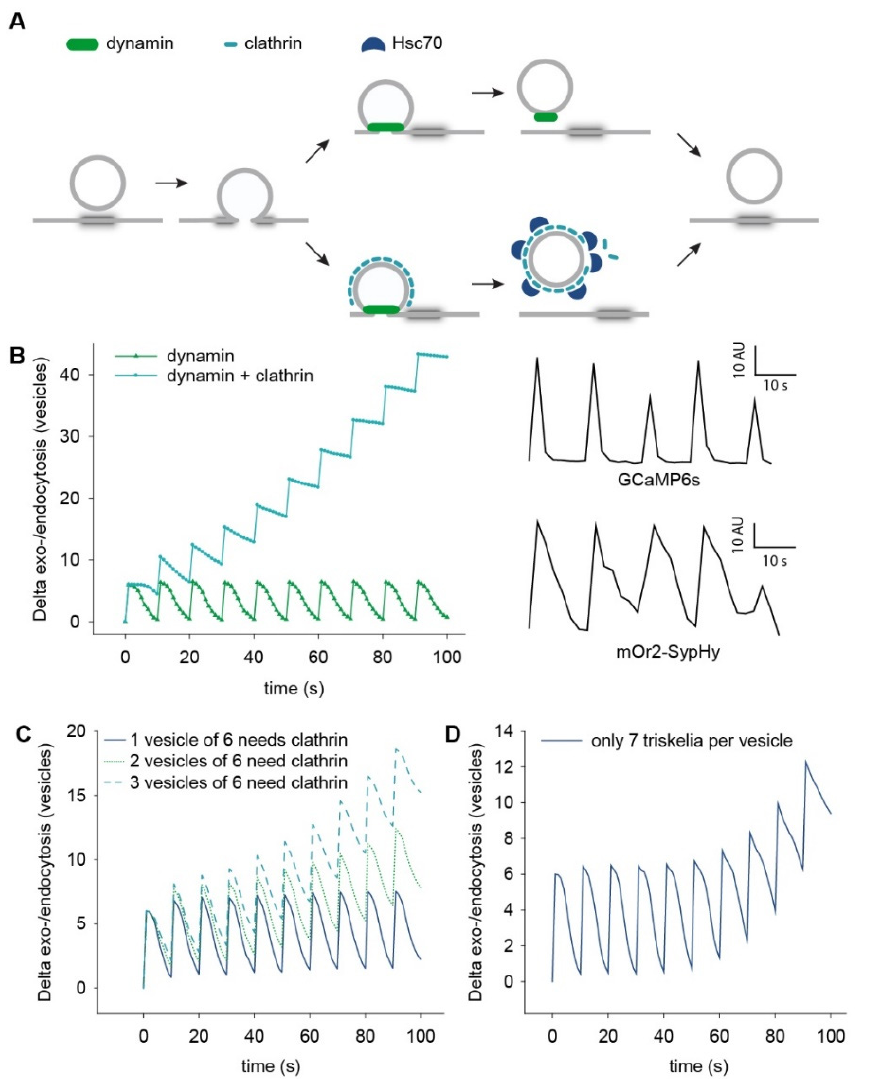
Figure 2. Simulations of the usage of three endocytosis cofactors during spontaneous network activity, ( A ), models of endocytosis tested in the simulations. To be endocytosed, each vesicle either needs to accumulate a su ffi cient number of dynamin molecules, which are quickly released after endocytosis, or, in addition to dynamin, a full clathrin coat is also required, which is then removed by Hsc70. ( B ), Results of the simulations showing the di ff erence between the number of exo- and endocytosed vesicles in both of the tested hypotheses. Dynamin is supplied in necessary copy numbers, and can be involved in endocytosis at every step, while in the case of an absolute requirement for clathrin, endocytosis does not balance exocytosis. The inset to the right shows an indication of the spontaneous network activity modeled here, in the form of fluorescence intensity changes of a calcium sensor (GCaMP6s, top), and of a vesicle endo- / exocytosis indicator (mOr2-SypHy, bottom) recorded in live boutons during spontaneous activity. For the full statistics of such measurements, see [47]. ( C ), We tested whether endocytosis can balance exocytosis when only a fraction of the released vesicles require a full clathrin coat. When one vesicle out of six required clathrin, exo- and endocytosis are balanced reasonably well. ( D ), Exo- and endocytosis can also not be balanced when as few as seven triskelia are required for each vesicle. The models were performed based on data obtained in cultured rat hippocampal neurons, as indicated in the main